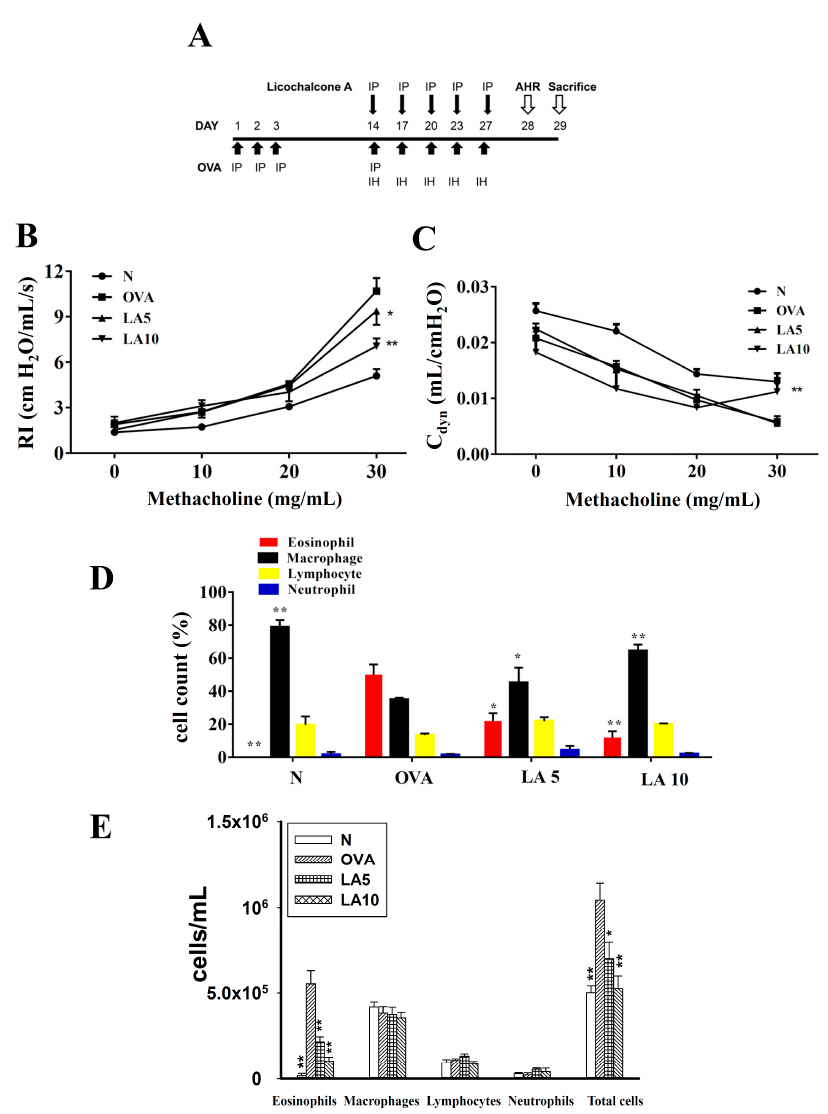
Figure 1. The e ff ect of licochalcone A (LA) on airway hyper-responsiveness (AHR) and cell counts in bronchoalveolar lavage fluid (BALF) of asthmatic mice. ( A ) On days 1–3 and 14, mice were sensitized with ovalbumin (OVA) by intraperitoneal injection (IP) and challenged with 2% OVA inhalation (IH) on days 14, 17, 20, 23, and 27. One hour before the OVA challenge or methacholine inhalation, mice were treated with LA or DMSO ( n = 12 mice / group). ( B ) AHR was measured as a percentage of lung resistance (RI) from baseline normal (N) and ( C ) dynamic lung compliance (C dyn ). ( D ) Inflammatory cells were measured and the percentage of inflammatory cells in the BALF presented. ( E ) Inflammatory cells and total cells were measured in BALF. Three independent experiments were analyzed, and data were presented as mean ± SEM. * P < 0.05 compared to the OVA control group. ** P < 0.01 compared to the OVA control